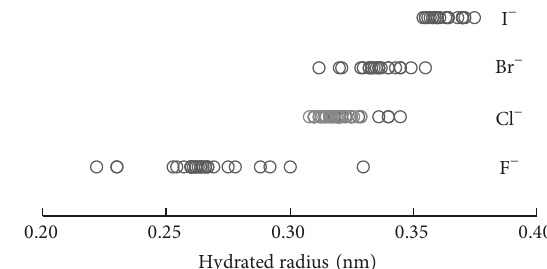
Figure 7: Compilation of hydrated anion radii reported in the literature [33, 34].